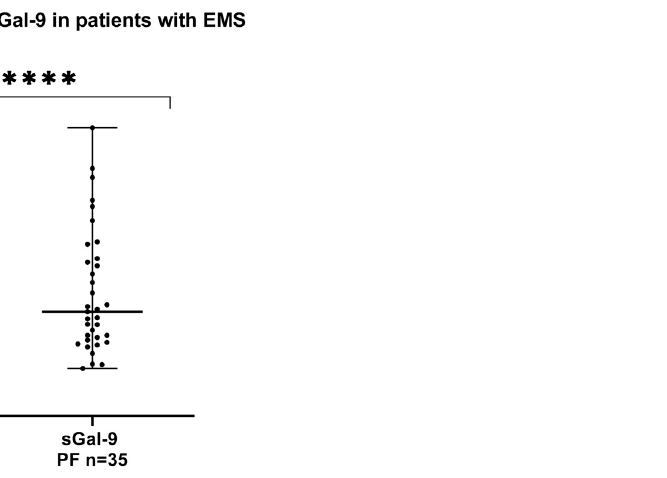
Figure 4. Levels of sGal-9 (ng/mL) in the plasma and peritoneal fl uid of patients with endometrio- sis. The median value with the following signs indicate statistically signi fi cant di ff erences: ***** p < 0.00001.